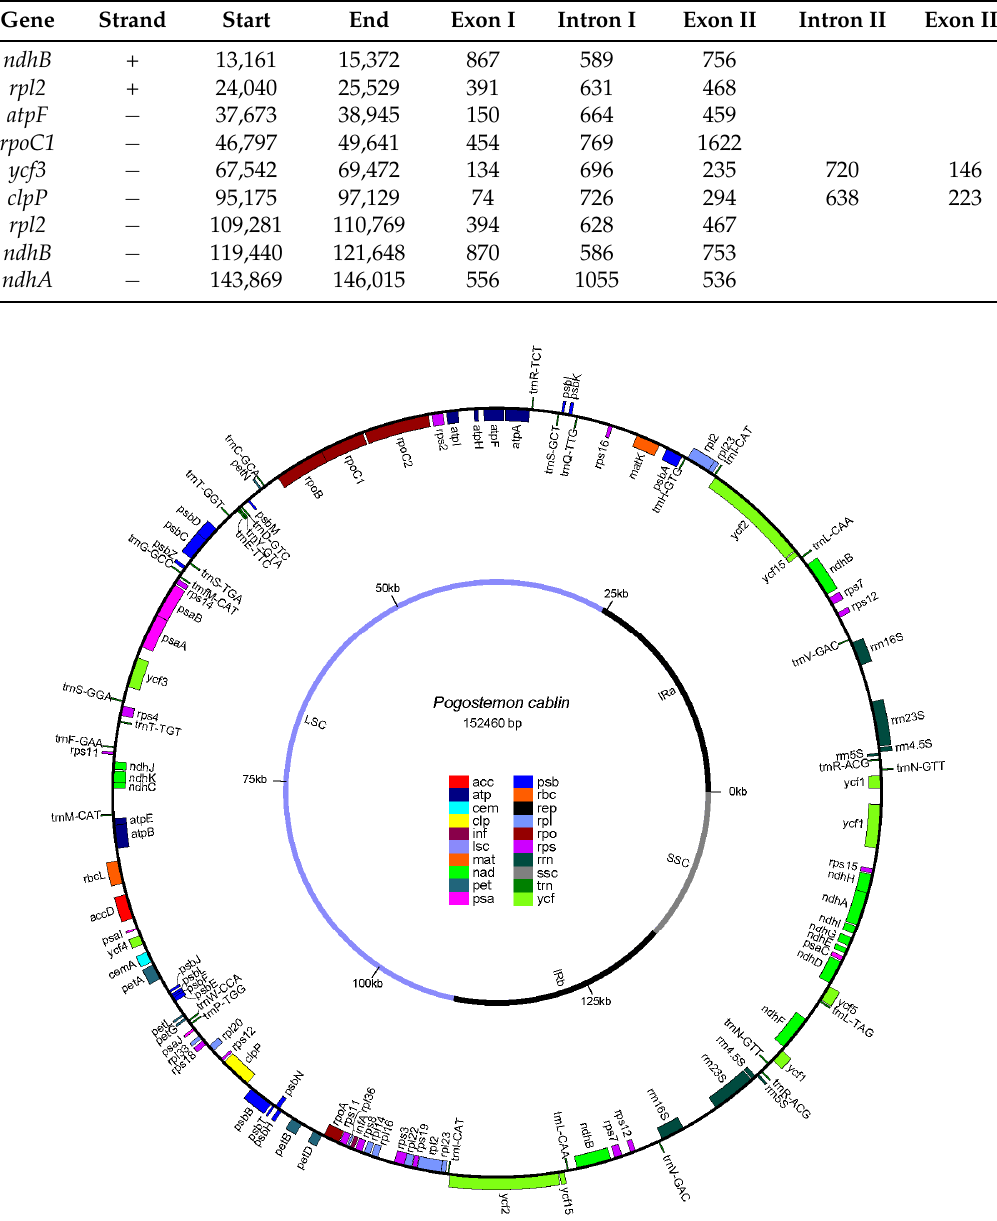
Figure 2. Genome schema of the P. cablin chloroplast genome. Genes inside the circle are transcribed clockwise, and counterclockwise transcribed otherwise. Fill colors represent different functional groups that specific genes fall into.